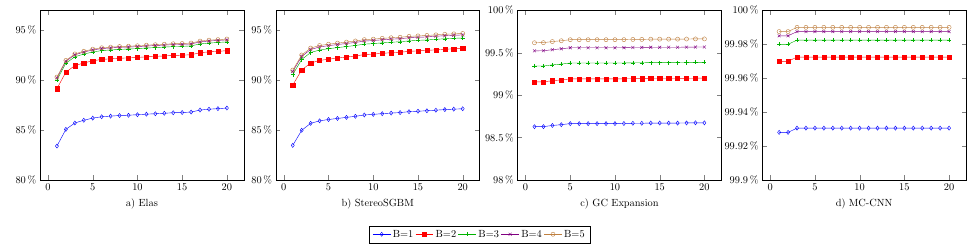
Figure 10. Values of the COV metric when EEMM was used with algorithms: ( a ) ELAS, ( b ) Stere- oSGBM, ( c ) GC Expansion and ( d ) MC-CNN.